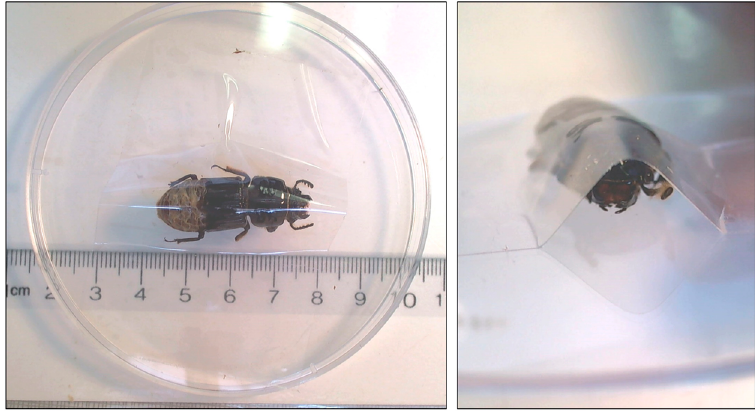
Figure 2. Photos of procedure used to apply restraint stress to beetles in both experiments. Each beetle was taped down to a petri dish lid using clear packing tape, which physically immobilized the body, head and legs of the specimen.